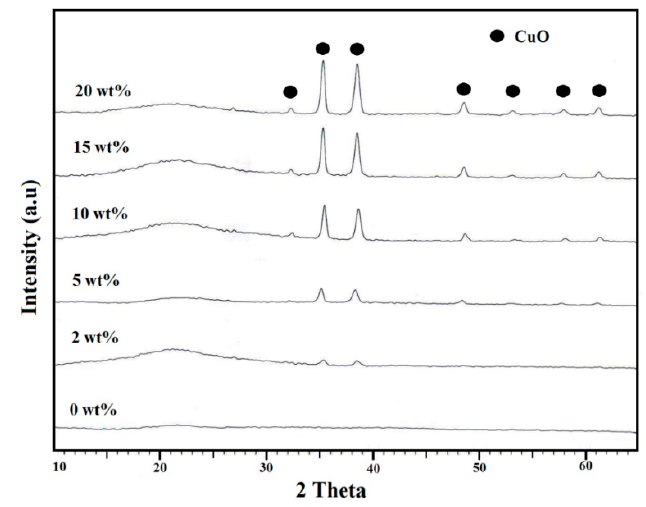
Figure 1. XRD patterns of various Cu/SiO 2 catalysts.